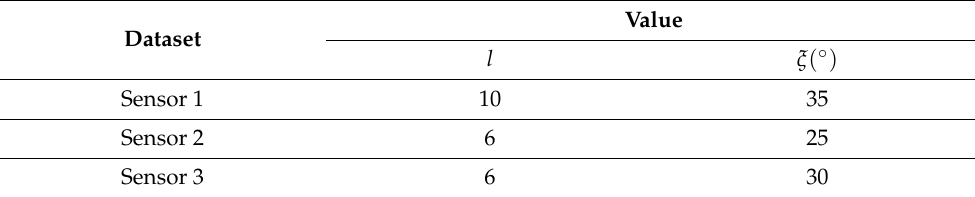
Table 4. Optimal SDP parameters for different datasets.